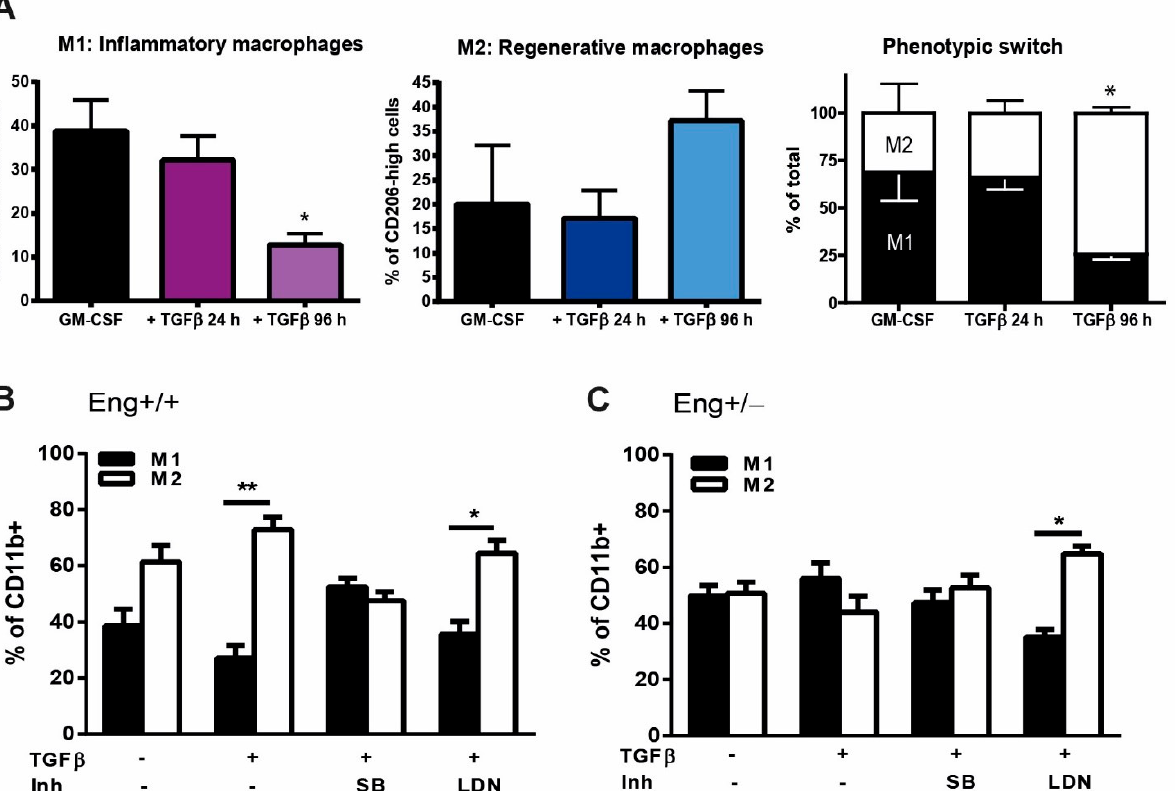
Figure 3. TGF β signaling influences macrophage subtype differentiation. ( A ) Macrophages from Eng+/+ mice cultured with either GM-CSF for 7 days or in the presence of TGF β (2.5 ng/ µ L) for 24 h and 96 h. The macrophage phenotype was determined based on the expression of Ly6C high (M1) and low (M2) of the CD11b expressing macrophages. * p = 0.001 difference in the number of M1 and M2 between GM-CSF vs. TGF β stimulation for 96 h. ( B , C ) BM isolated monocytes from Eng+/+ ( B ) and Eng+/ − ( C ) mice were cultured in the presence of GM-CSF in the presence or absence of TGF β (2.5 ng/ µ L), SB (10 µ M), or LDN (100 nM). The macrophage subtype was determined based on the expression of Ly6C high (M1) and low (M2) of the CD11b expressing macrophages. * p = 0.007; ** p <